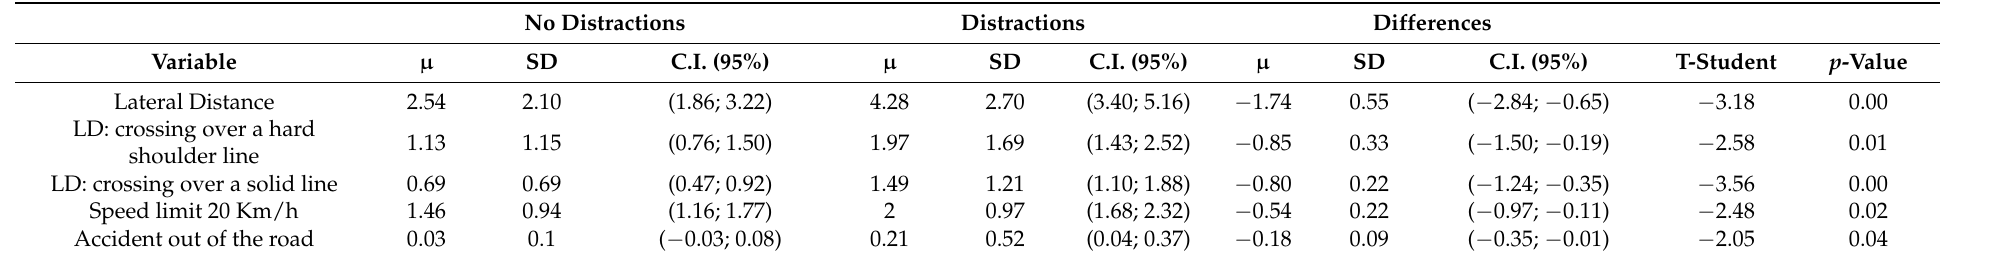
Table 4. Comparison of driving performance of the drivers during the two drives.